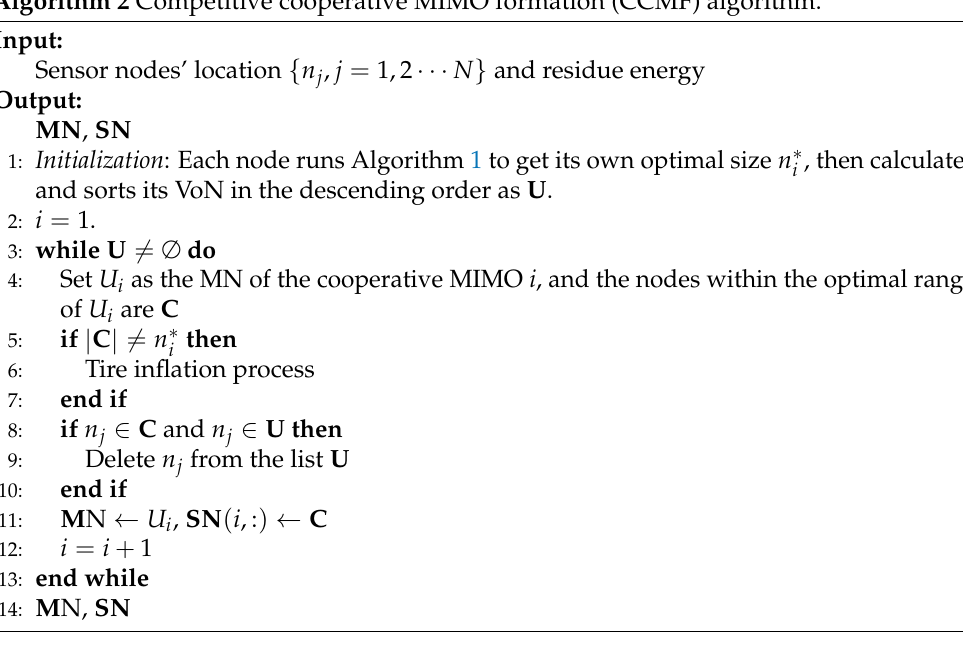
Algorithm 2 Competitive cooperative MIMO formation (CCMF) algorithm.